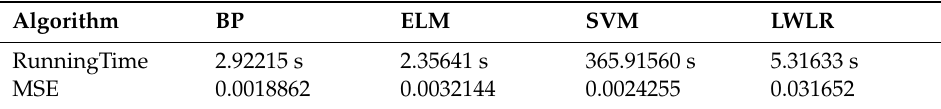
Table 5. The running time and mean square error (MSE) comparison of the four methods.